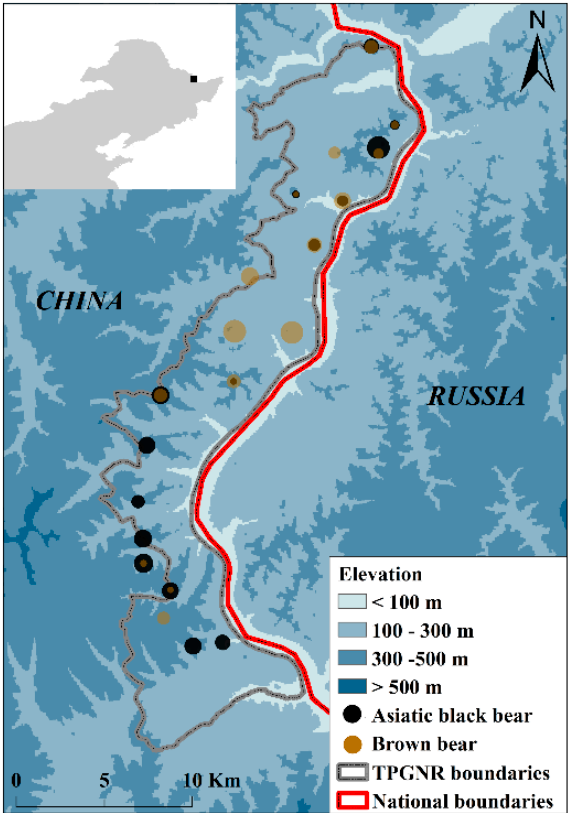
Figure 1. Study area and camera–trapping sites indicating where Asiatic black bears and brown bears exist in Taipinggou National Nature Reserve, Heilongjiang Province, China, 2017. The black and brown points show the center of each camera traps, and their size indicated the relative abundance index of Asiatic black bears and brown bears in independent camera traps.